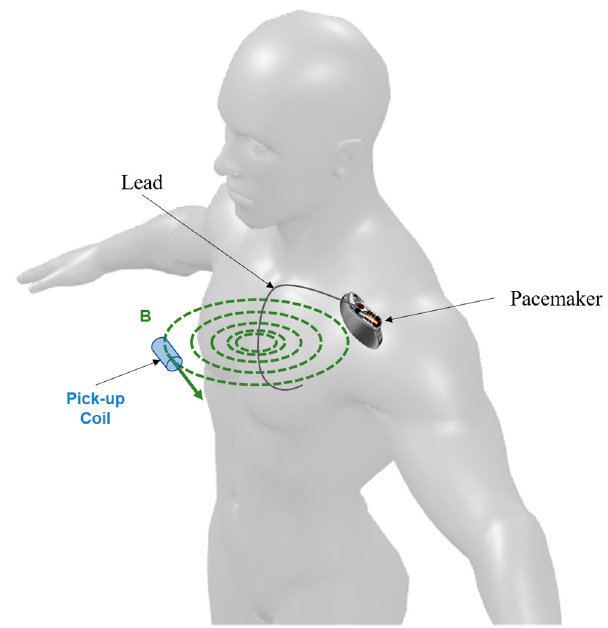
Figure 1. Schematic representation of the sensor operating principle.